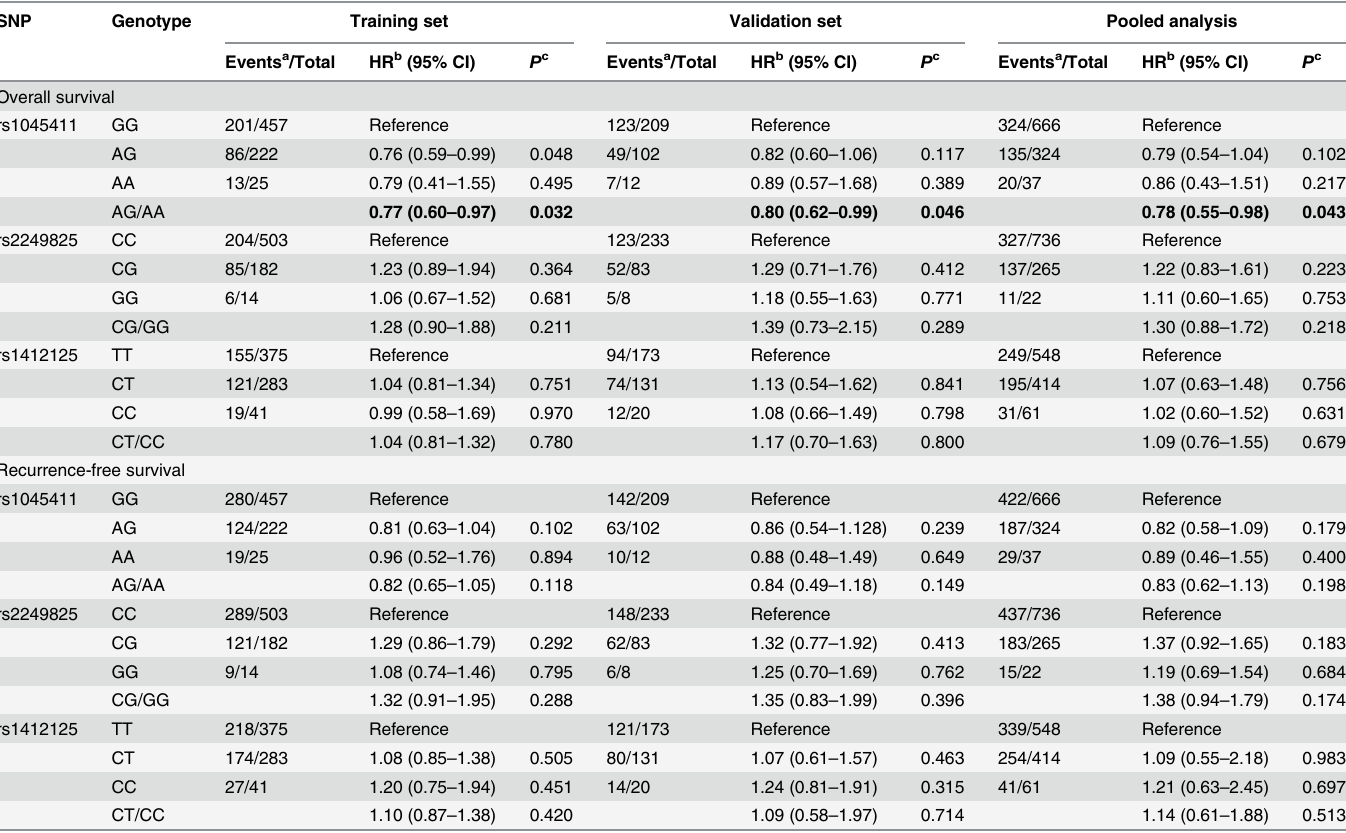
Table 1. Association of HMGB1 SNPs and clinical outcome of gastric cancer